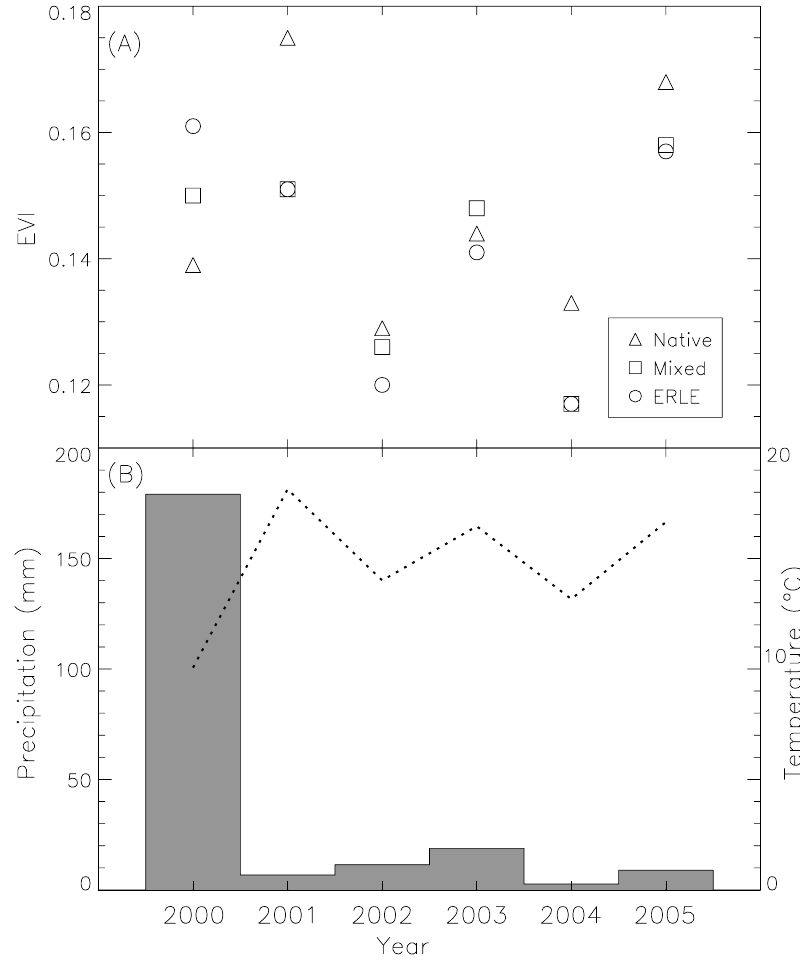
Figure 2. (A) The Enhanced Vegetation Index (EVI) in October (the Moderate Resolution Imaging Spectroradiometer [MODIS] period 19 and 20) of the extreme wet year (2000) and normal years (2001-2005) for field sites in a semi-arid environment of southern Arizona, USA across a gradient Eragrostis lehmanniana invasion (native grasslands [Native], a mixture of E. lehmanniana and native grasses [Mixed], E. lehmanniana invaded grasslands [ERLE]). (B) Mean October temperature (dashed line) and precipitation (gray bars) from 2000 to 2005 of the study region. This figure is adapted from Huang and Geiger [46] with permission from